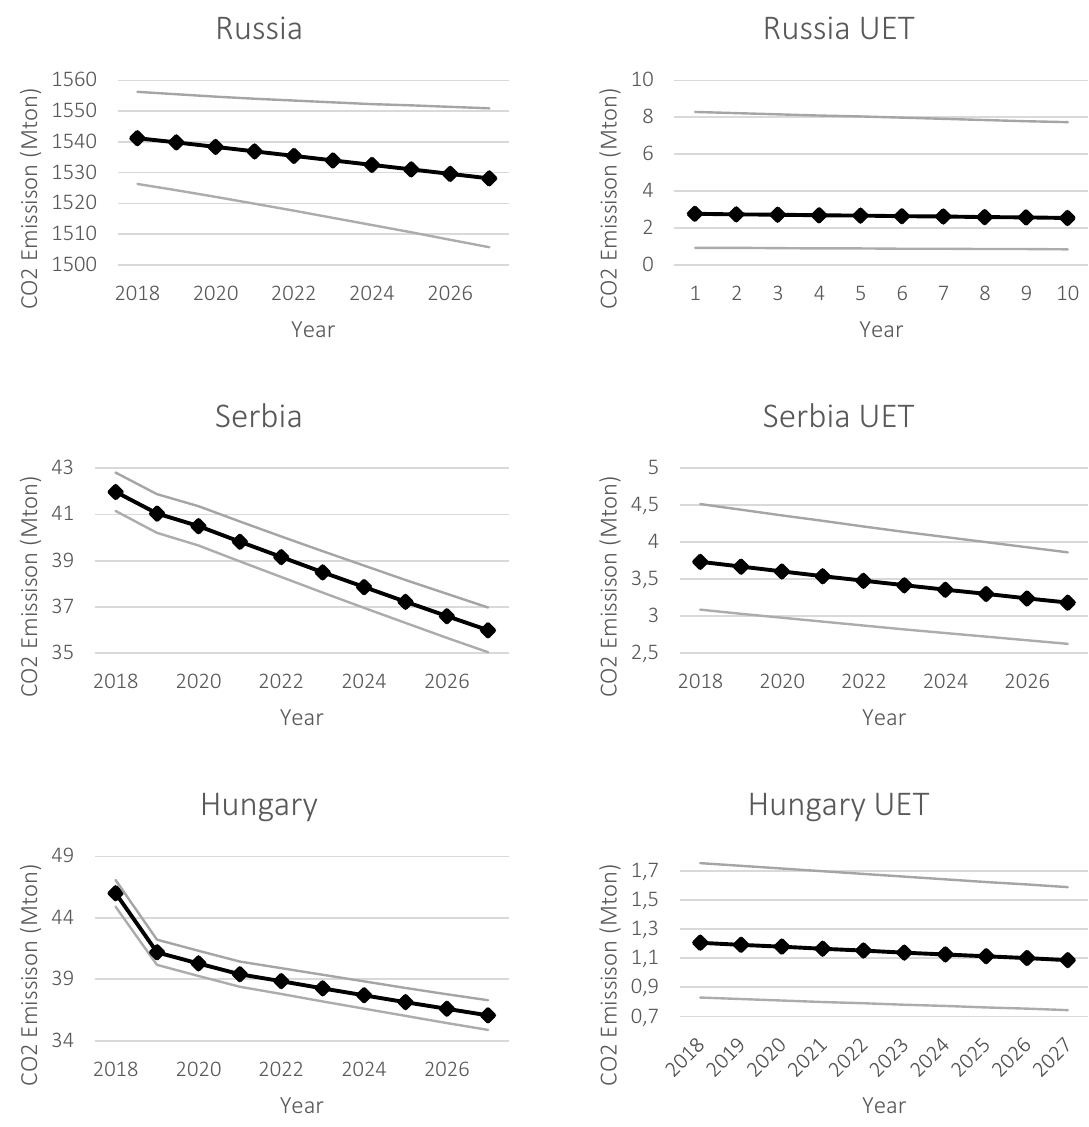
Figure A2 (cont.). Forecast results and UETs for each